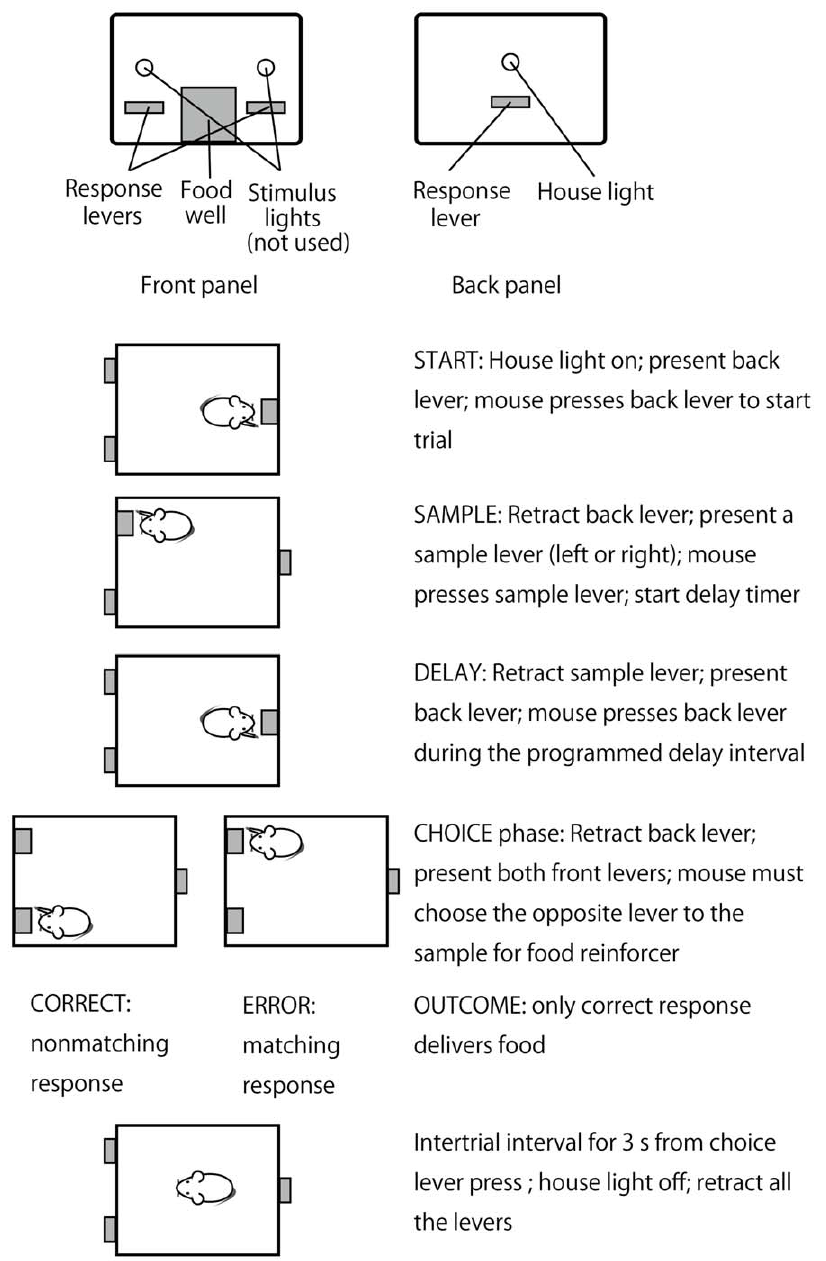
Figure 2. Schematic illustration of apparatus and experimental procedure. (A) The front and back panel of the operant conditioning chamber, and (B) the delayed nonmatching-to-position task sequence.